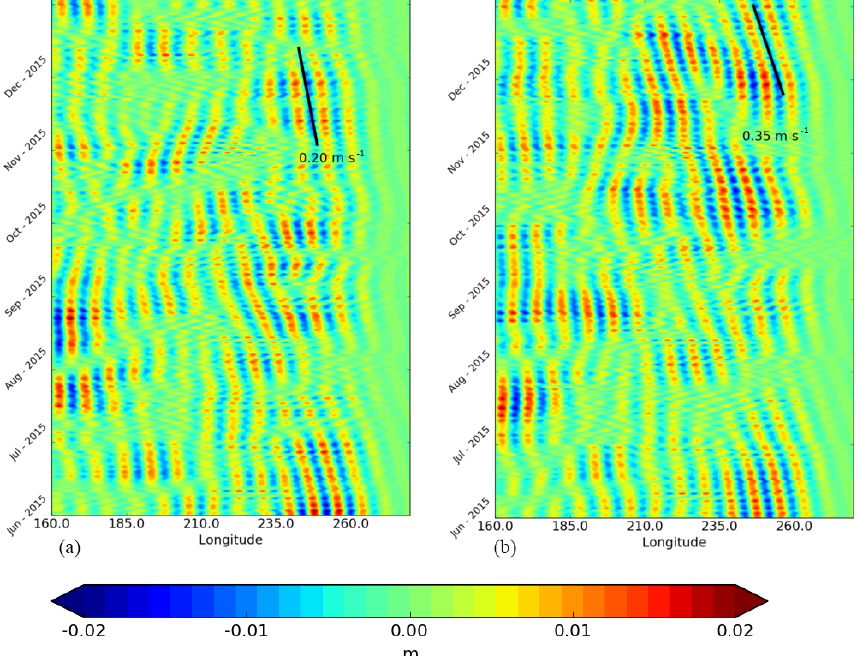
Figure 14. Hovmöller diagram of 28–40-day (33 days) band-passed SSH anomalies at 4 ◦ N referenced to the temporal annual mean of June–December 2015 for the REF experiment (a) and for the SMOSexp experiment (b) . The propagation speeds of 0.20 and 0.35ms − 1 (solid lines) are representative of the propagation speed for the 28–40-day